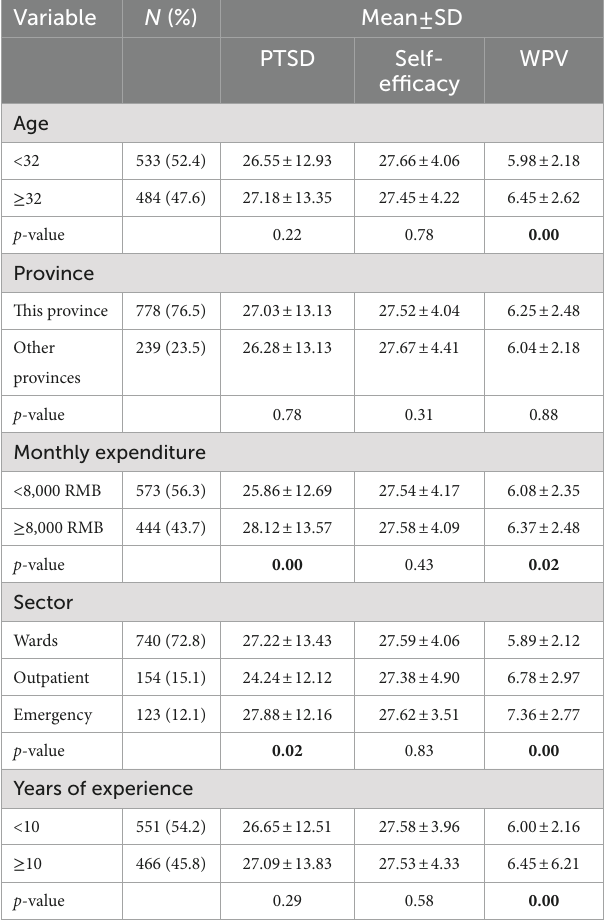
TABLE 1 Relationship between demographic characteristics and PTSD, self-efficacy, and WPV. Variable